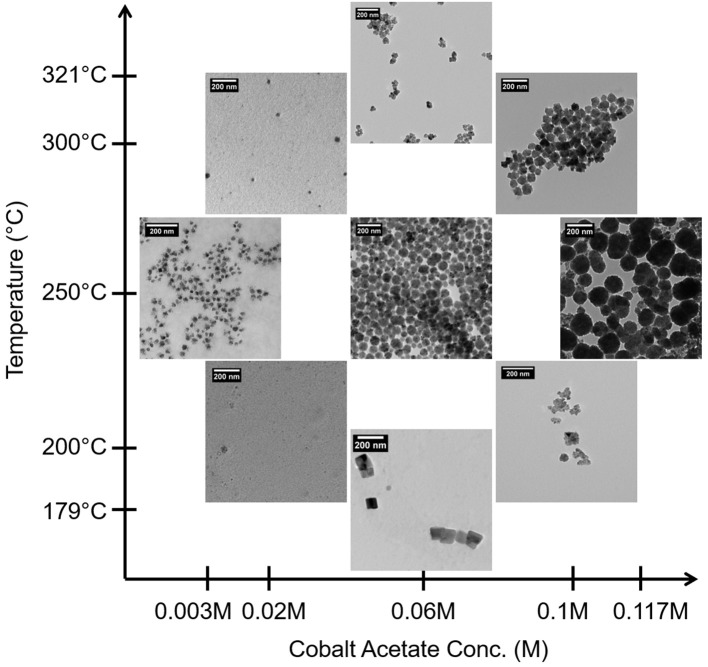
TEM images of CCD CoOx samples.